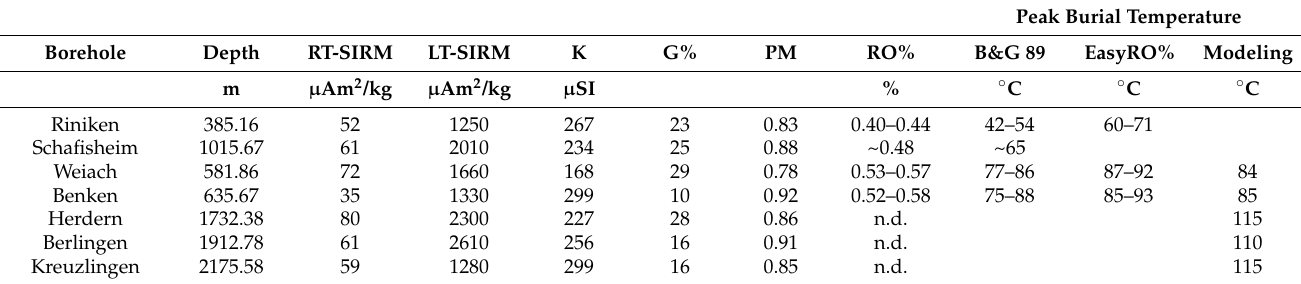
Table 2. Opalinus Clay data, including depth location of the samples in the borehole. RT-SIRM: room-temperature saturated isothermal remanent magnetization; LT-SIRM: low-temperature saturated remanent magnetization (10 K); K: low-field magnetic susceptibility; G%: goethite proxy derived by the slope of RT-SIRM during cooling. The PM value was inferred from the LT-SIRM drop between 10 K and 35 K. PM = (LT-SIRM 10K − LT-SIRM 35K )/LT-SIRM 10K . RO%: percentage of vitrinite reflectance. Peak burial temperature derived from an equation by Barker and Goldstein [28]. EasyRO% and modeling are data from Mazurek et al.